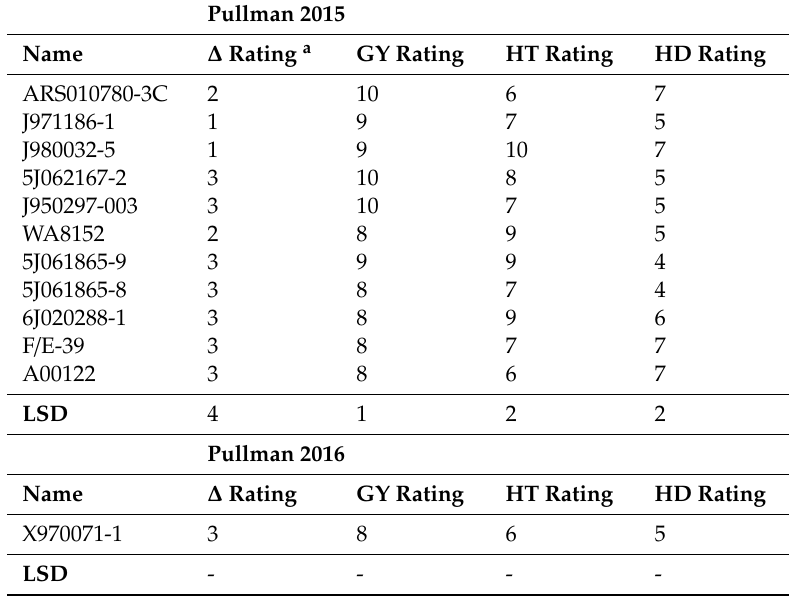
a Standard Deviation. -, N / A. Table 2. Low ∆ , high grain yield genotypes from each Pacific Northwest environment, including index ratings for ∆ , grain yield (GY), plant height (HT), and heading date